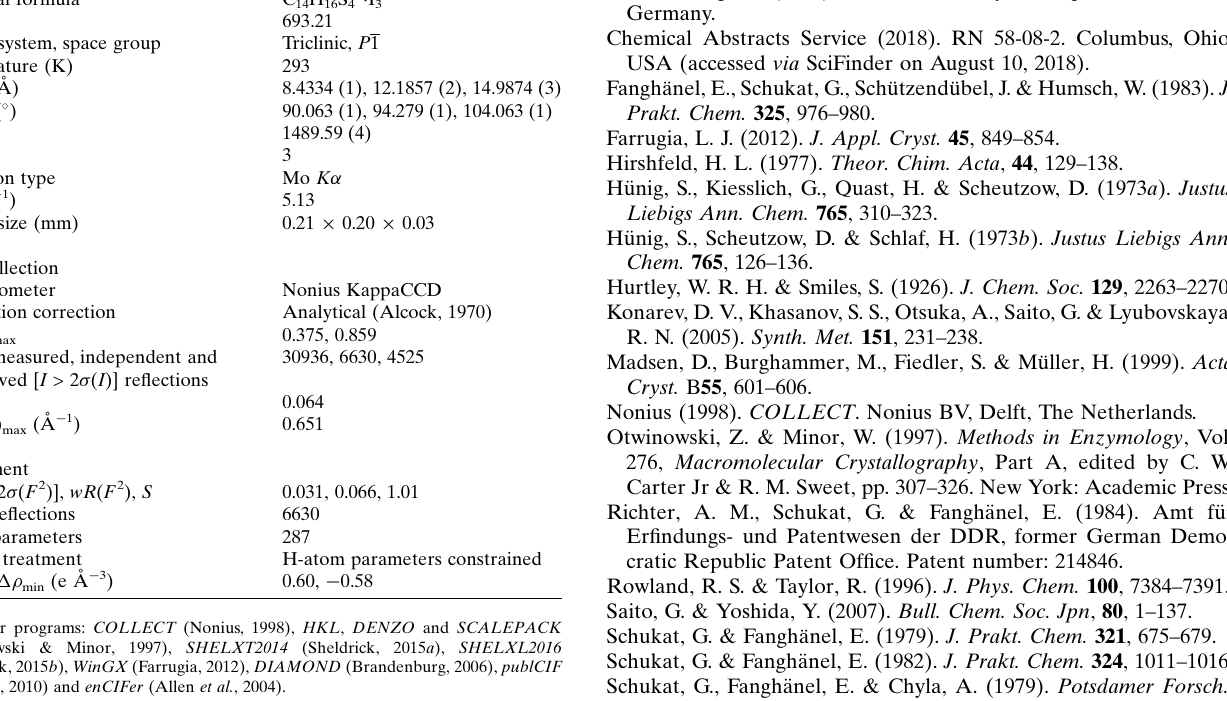
Table 2 Experimental details. Crystal data Chemical